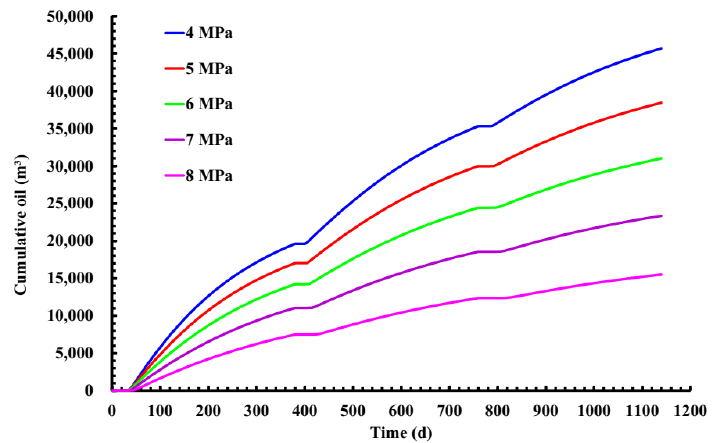
Figure 12. The effect of bottom hole